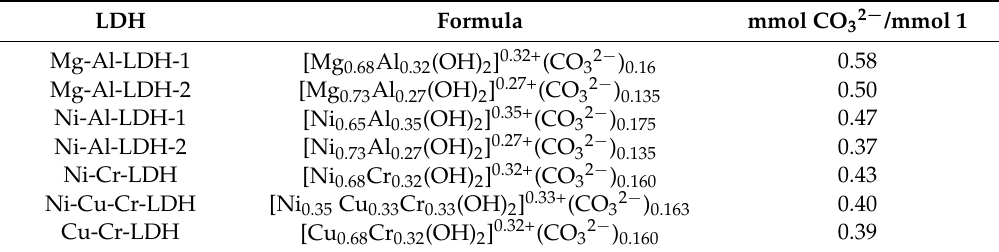
Table 8. Formulae of LDH catalysts and molar ratio of carbonate to 1 . Table 8 . Formulae of LDH catalysts and molar ratio of carbonate to 1